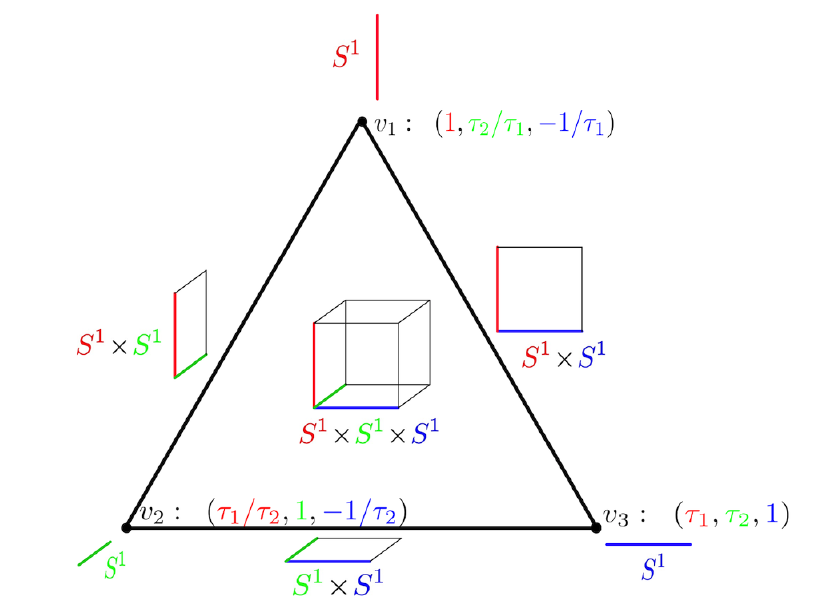
Figure 3 . Squashed S 5 as a T 3 (cid:12)bration over a triangle: the cube, whose opposite faces are identi(cid:12)ed, represents the torus. At the edges of the triangles the torus collapses to a T 2 ; at the vertices it collapses to S 1 . At each vertex we also display the correctly normalized equivariant parameters corresponding to the three